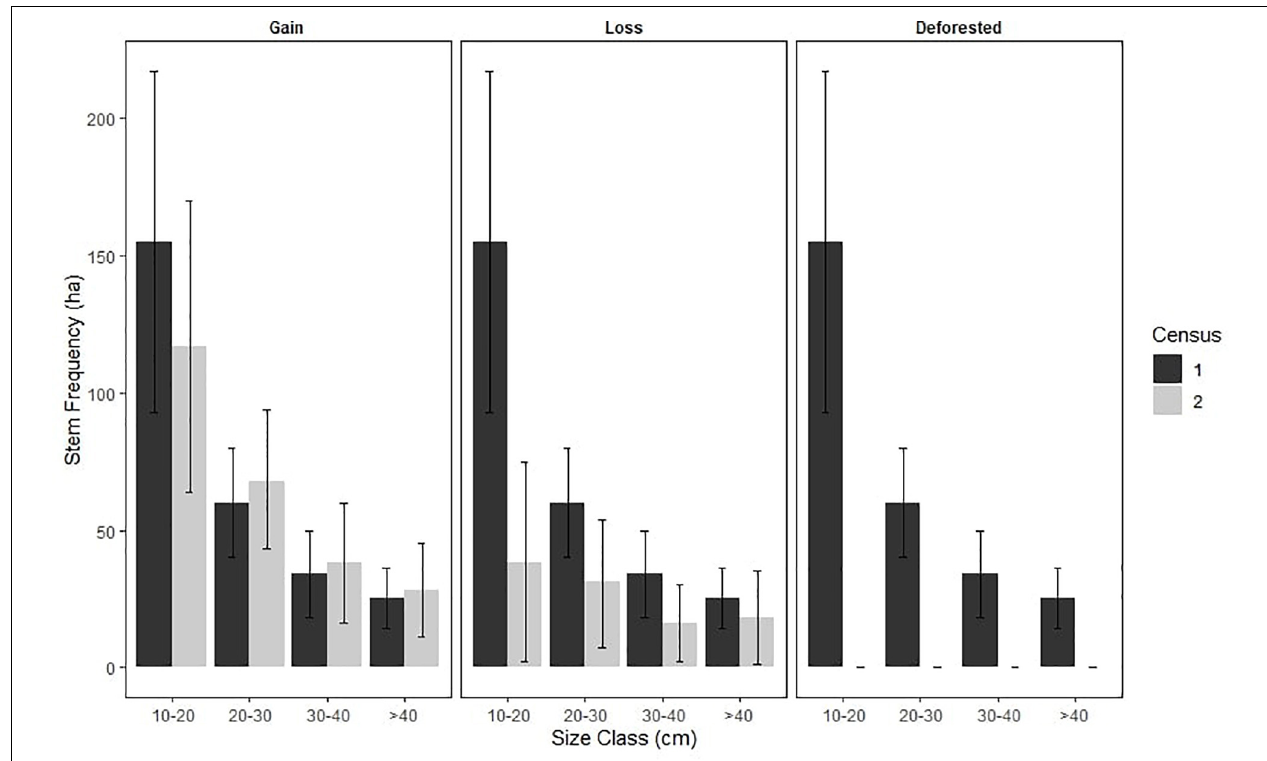
FIGURE 8 | Frequency distribution of stems (ha − 1 ) in census 1 and 2 for plots that gained AGB (undisturbed plots), plots that lost AGB (degraded plots) and the deforested plot (Plot 6). Deforested plot (Plot 6) was separated from other AGB loss plots as it represented total deforestation rather than degradation. Error bars show 95% confidence